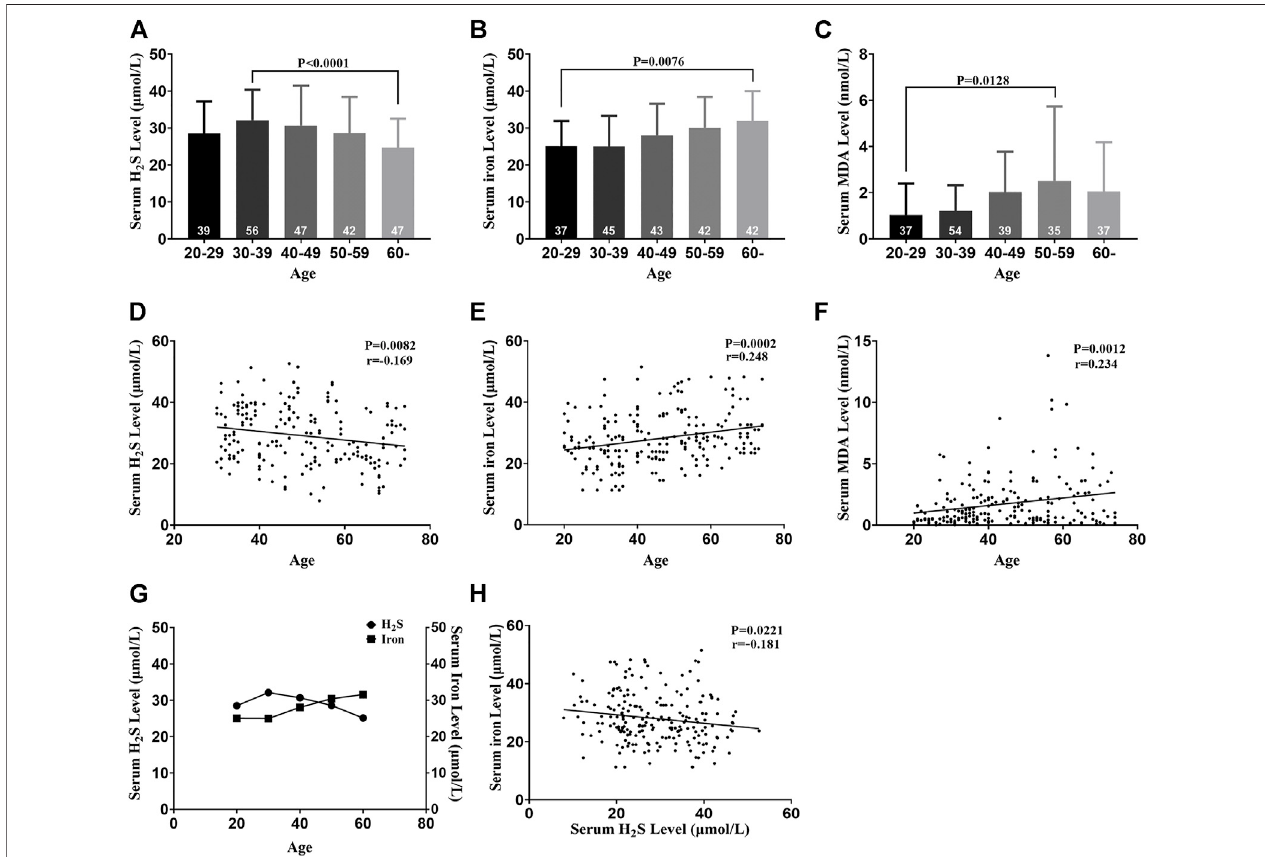
FIGURE2| SerumH 2 S,iron,andMDAlevelschangewithaginginhealthyparticipants. (A) SerumH 2 Slevelsof fi vegroups. (B) Serumironlevelsof fi vegroups. (C) Serum MDA levels of fi ve groups. (D) Serum H 2 S level was negatively correlated with age. (E) Serum iron level was positively correlated with age. (F) Serum MDA level waspositivelycorrelatedwithage. (G) SerumironandH 2 Slevelschangedwithaging. (H) SerumironlevelwasnegativelycorrelatedwiththeserumH 2 Slevel.Resultsare means ± SEM. A p -value of < 0.05 was considered signi fi cant. MDA: